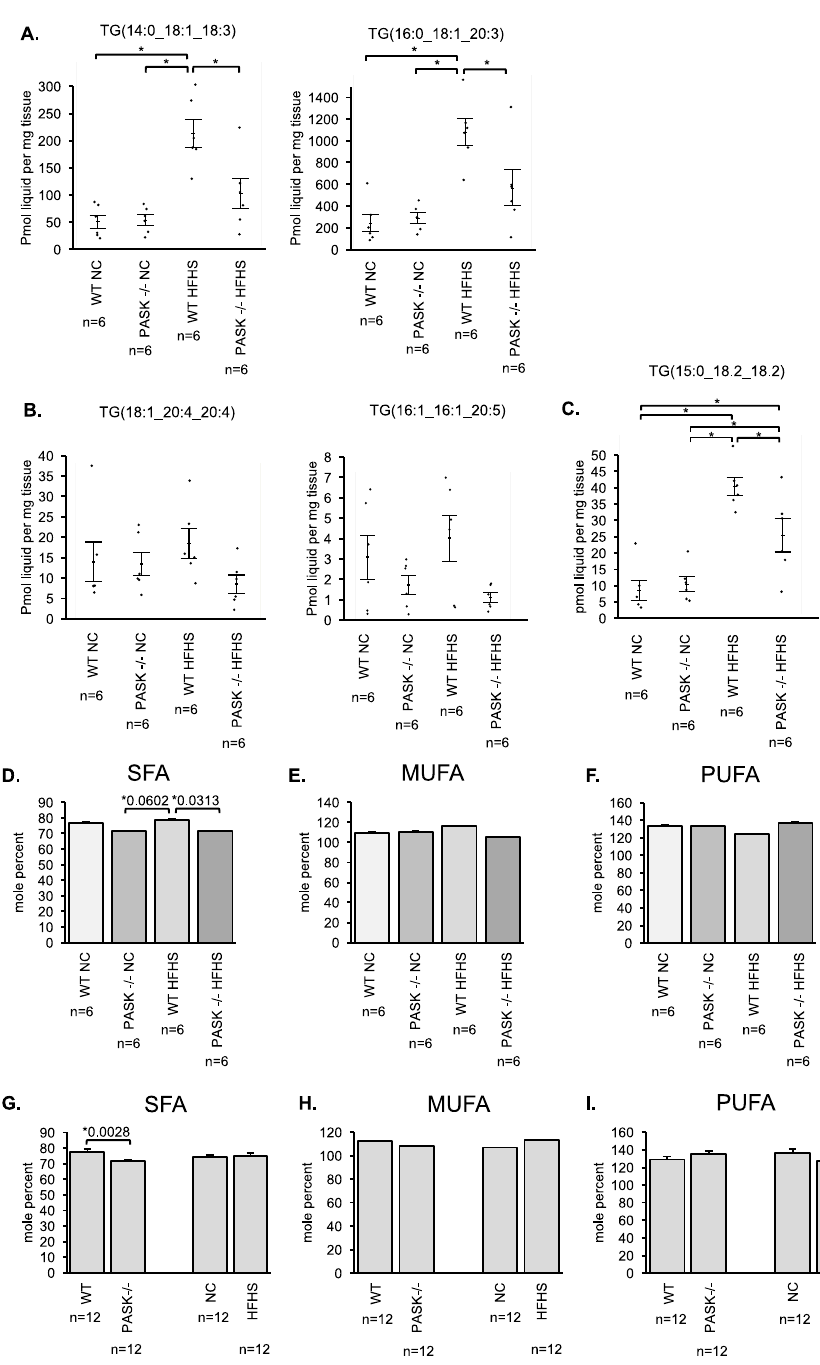
Figure 5. Saturated fatty-acid side chains are elevated in WT male mice on the HFHS diet but not PASK − / − male mice on the HFHS diet. ( A ) Examples of PAS kinase-dependent protection from triglyceride accumulation. ( B ) Examples of triglycerides that were not significantly affected by the HFHS diet. ( C ) One triglyceride that increased in response to the HFHS diet in the PASK − / − mouse. Bars represent SEM. * p < 0.05 when analyzed by two-factor ANOVA and Tukey post-hoc test. ( D – F ) Data in Figure 4 was analyzed for saturated fatty acid (SFA), monounsaturated fatty acid (MUFA), and polyunsaturated fatty acid (PUFA) side chains within each triglyceride. Side-chain abundance was calculated using mole percent ratio (percentage of moles of each fatty-acid side chain compared to total mole concentration). p < 0.1 when analyzed by two-factor ANOVA and Tukey post-hoc test. ( G – I ) One-factor (genotype or diet) analysis of ( D – F ). p < 0.05 when analyzed by student’s t-test.